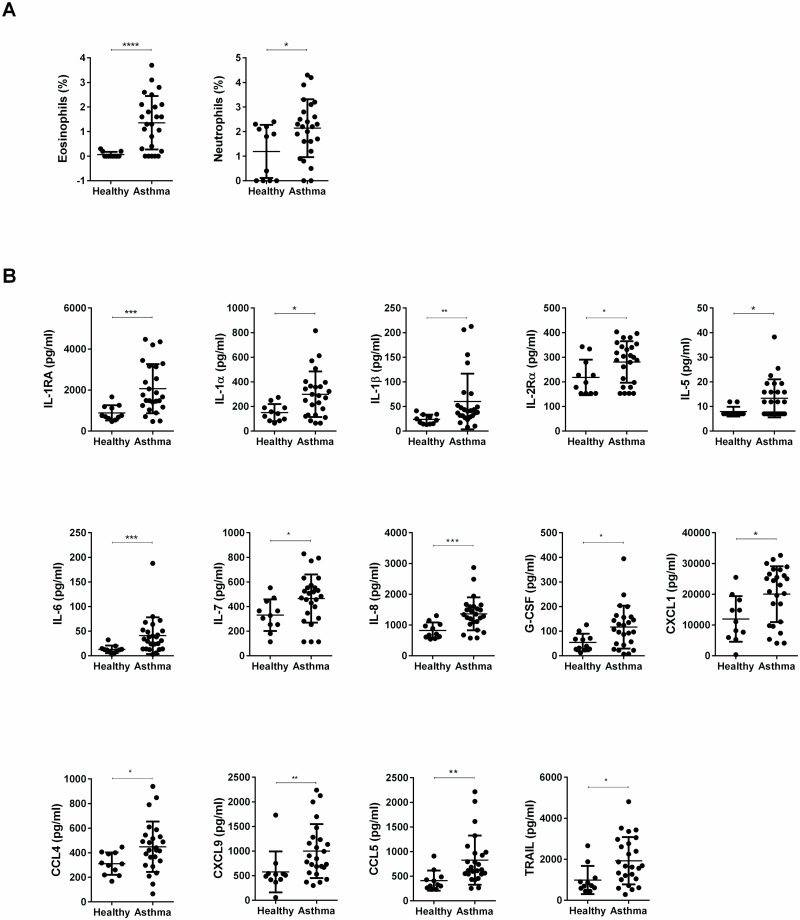
Differences in cell and cytokine levels in BAL fluids in healthy controls vs. asthma.(A) Percentages of eosinophils and neutrophils in the BAL fluids. (B) Concentrations of IL-1RA, IL-1α, IL-1β, IL-2Rα, IL-5, IL-6, IL-7, IL-8, G-CSF, CXCL1, CCL4, CXCL9, CCL5, and TRAIL in the BAL fluids. Data are expressed as means ± SEM. * = P < .05, ** = P < .01, *** = P < .001, **** = P < .0001.